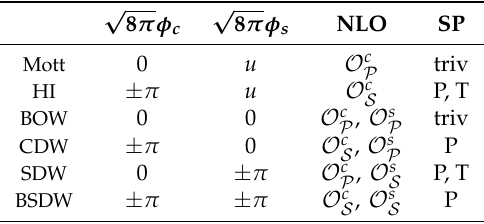
Table 1. Left-hand side: Classification of the insulating phases for H SG at half-filling. The first column denotes the two possible pinning values for the charge ( φ c ( x ) ) field. The second gives the value of the spin field, with u standing for “unpinned”. The third column denotes the non-vanishing NL order parameters O ν A , ν = c , s . Right-hand side: The phase without topological features are denoted by “triv", whereas we report the type of symmetry (T and or P) protecting the phases with degenerate edge